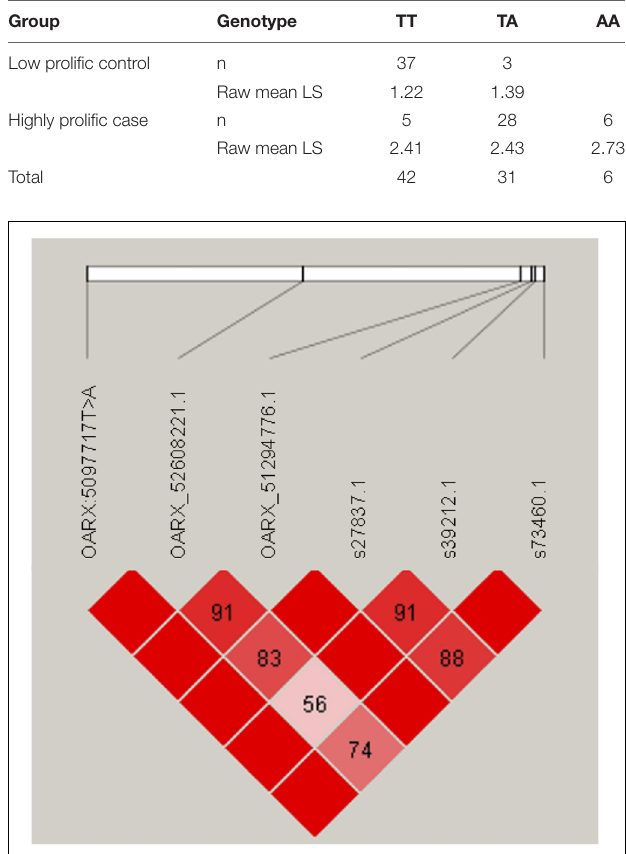
FIGURE 3 | Linkage disequilibrium (LD) plot. Generated by Haploview, pairwise LD between SNP markers (OARX: 50977717T > A and the five genome-wide significant LS-associated markers) is represented by the D’ value. Strong LD is represented in dark red boxes (D’ = 100) and weaker LD (D’ < 100) in lighter red